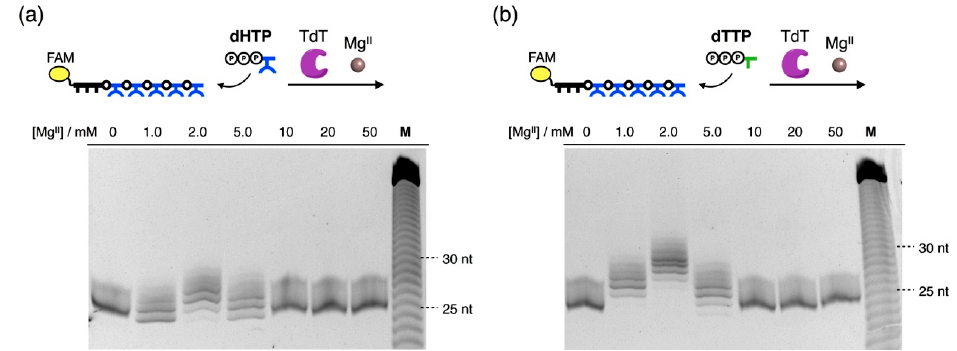
Figure 4. TdT-catalyzed elongation of ligand-bearing artificial DNA strands with ( a ) d H TP and ( b ) dTTP. Primer (5 ′ -FAM-dT 20 H 5 -3 ′ ): 5.0 µM, dTTP or d H TP: 100 µM (20 equivalents), TdT: 2 U/µL, MgCl 2 : 0, 1.0, 2.0, 5.0, 10, 20, and 50 mM, 37 °C, 24 h. The products were analyzed by denaturing